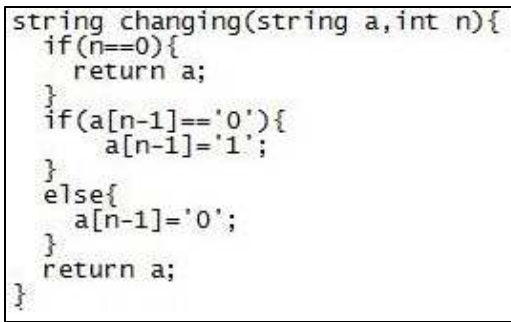
Figure A6. Function of one-bit change .